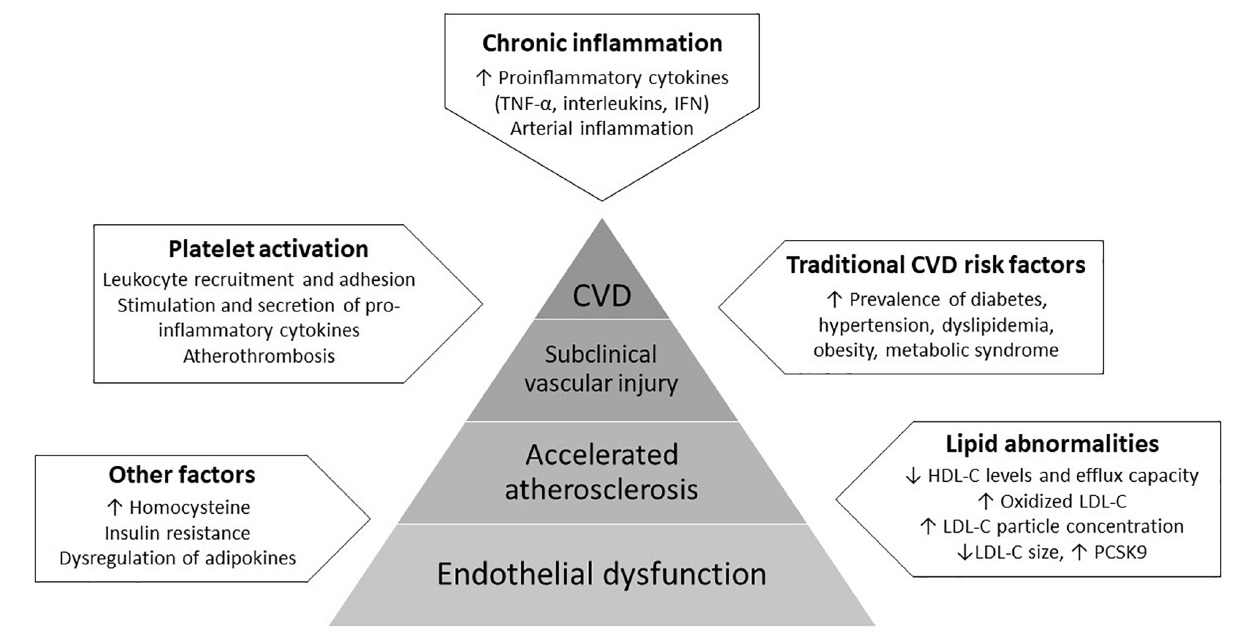
FIGURE 1 | Mechanisms of endothelial dysfunction in psoriasis involve complex interactions between the endothelium, proinflammatory cytokines, circulating lipids and platelets, and the increased prevalence of traditional cardiovascular risk factors. These factors act synergistically directly and indirectly activate endothelial cells and impair their function, resulting in a pro-atherogenic state, the subsequent development of subclinical vascular injury and eventually, clinically evident cardiovascular disease (CVD).